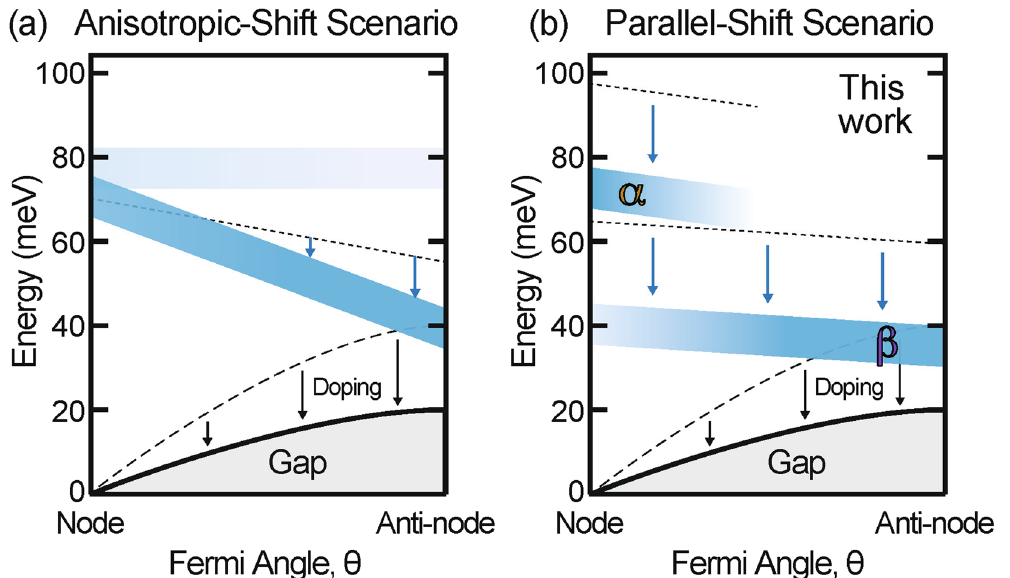
Figure 5. Two pictures of the main kinks in overdoped Bi2212. The strength of the kink is denoted by blue shading. ( a ) Continuous main kink, whose energy shift with overdoping is highly anisotropic, proposed in ref. 15. ( b ) Two separate kinks, whose energy shifts with overdoping are parallel and nearly isotropic, based on the present